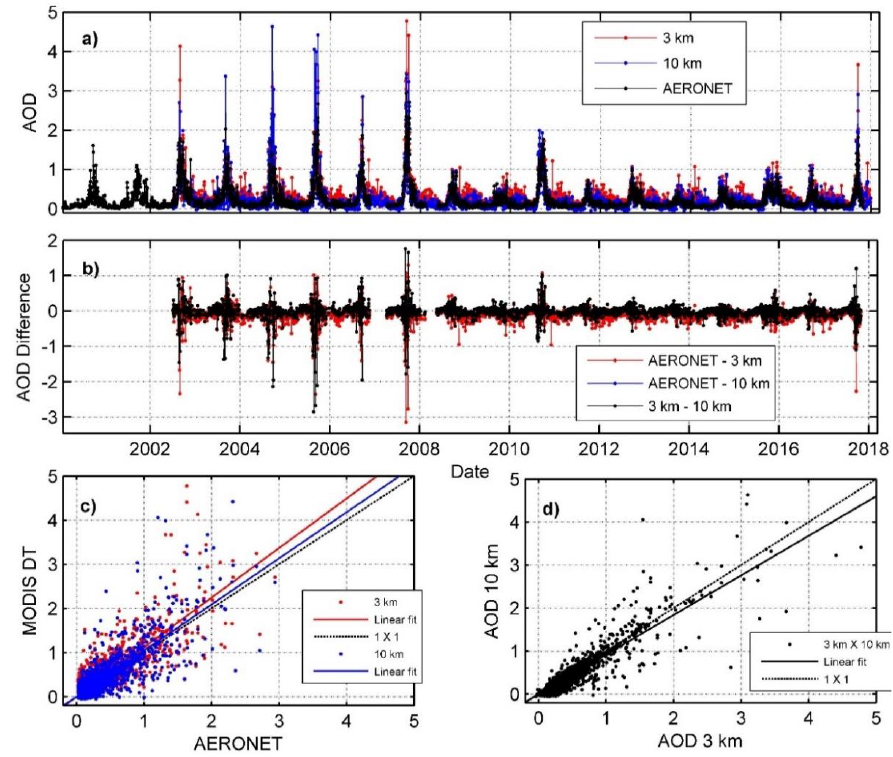
Figure 5. ( a ) Time series of AODs obtained by AERONET, MODIS DT 3 km, and MODIS DT 10 km for all analyzed sites. ( b ) Difference between the AODs obtained by AERONET and all MODIS DT data. ( c ) Linear regression with the integrated measurements of all sites for the AERONET AOD measurements and the MODIS DT 3 km and 10 km products. The dashed line represents the x = y line. ( d ) Linear regression between the AOD products MODIS DT 3 km and 10 km.